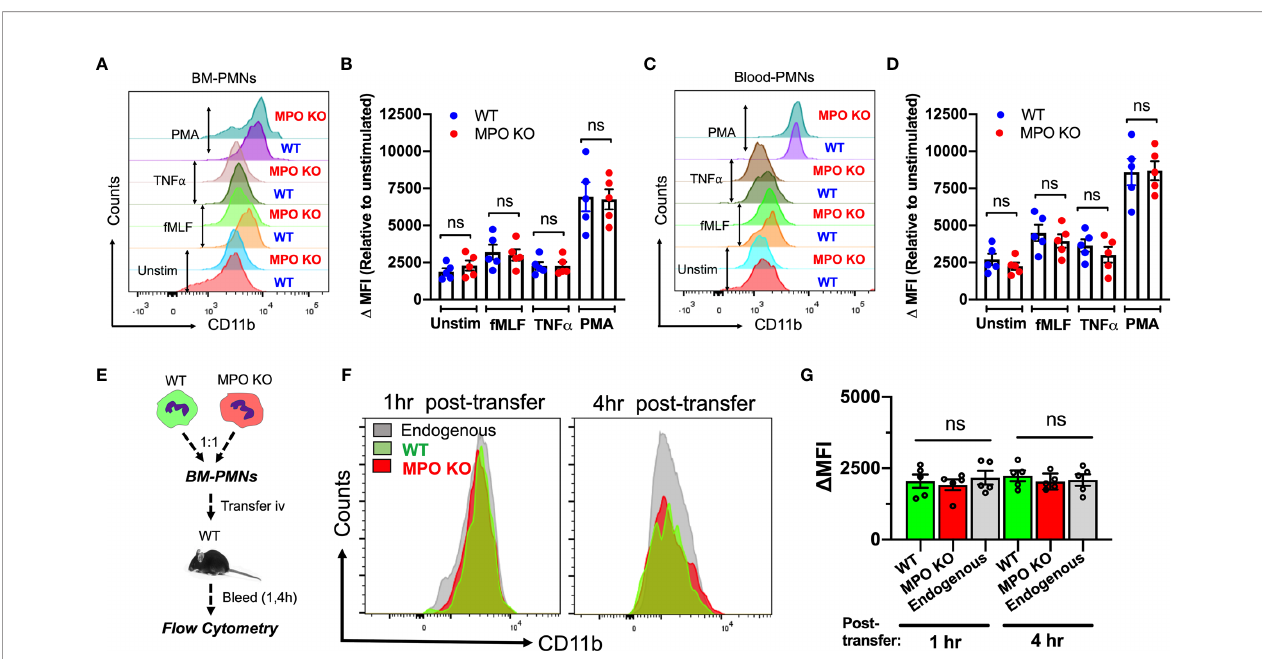
FIGURE 5 | CD11b surface expression is not altered by the genetic deletion of MPO. (A – D) CD11b expression was assessed by fl ow cytometry in BM-derived and circulating blood PMNs with/without ex vivo in fl ammatory stimulation. (A, B) Representative fl ow diagram and quanti fi cation of CD11b expression in BM-PMNs. (C, D) Representative fl ow diagram and quanti fi cation of CD11b expression in circulating PMNs. N=5 independent repeats per condition. (E – G) CD11b expression was assessed in fl uorescently labeled WT (green) and MPO KO (red) PMNs at 1 and 4hr following adoptive intravenous transfer into IL-1 b -stimulated (50ng, 1hr) WT recipient mice. (E) Schematic depicting experimental time line. (F, G) Representative fl ow diagrams and quanti fi cation reveal no signi fi cant differences in CD11b expression. N=5 mice per condition. ns not signi fi